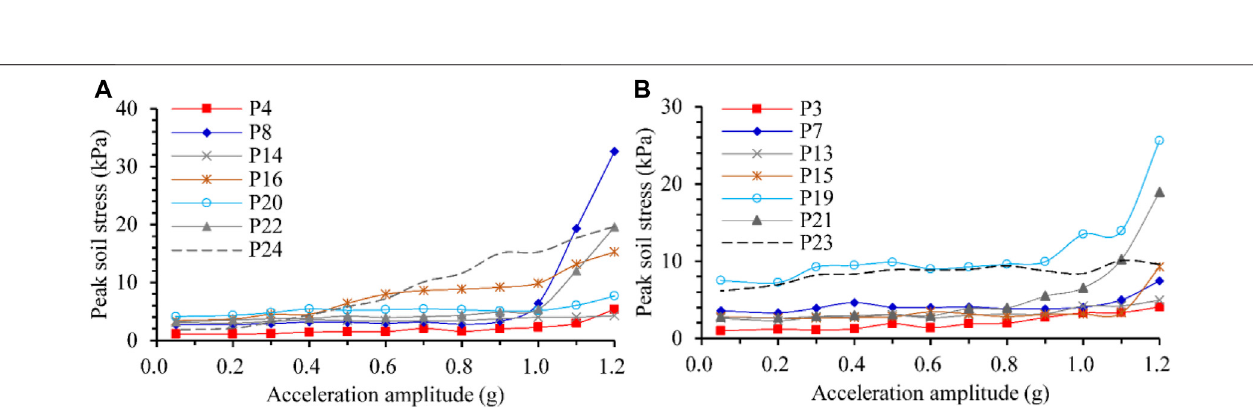
Frontiers in Earth Science |